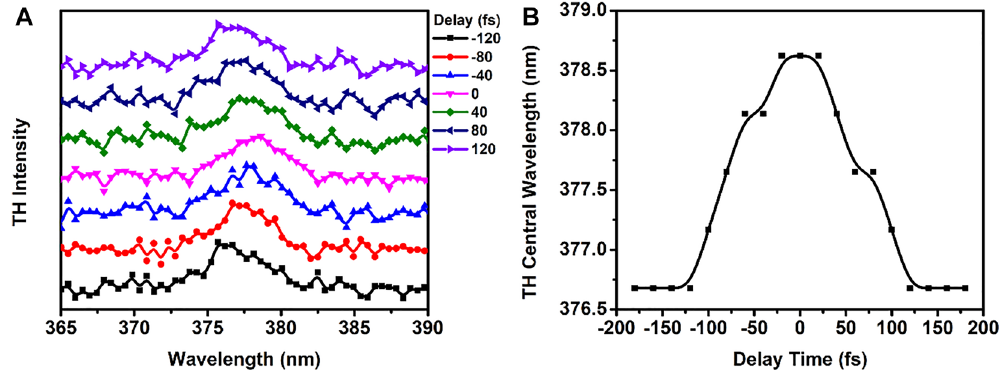
Figure 4: The pump-probe experimental results of THG. (A) The peak of the collected TH shifts with the delay time. (B) The central wavelength of the TH as a function of the delay